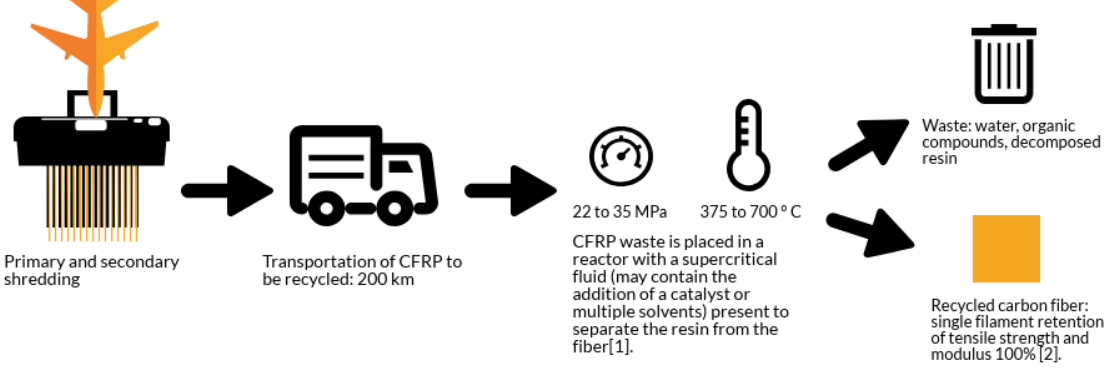
Figure 2. The solvolysis process when applied to aerospace CFRP EOL parts .